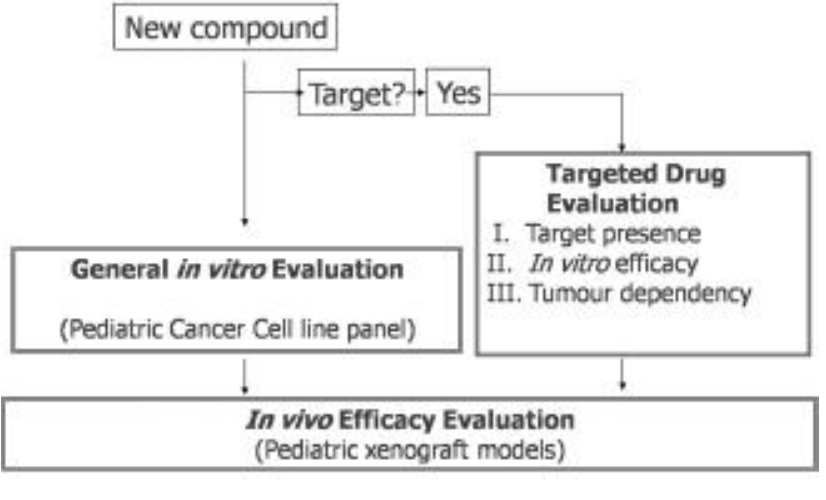
Figura 1. Flow chart for the investigation of new compounds in the ITCC Biology net-